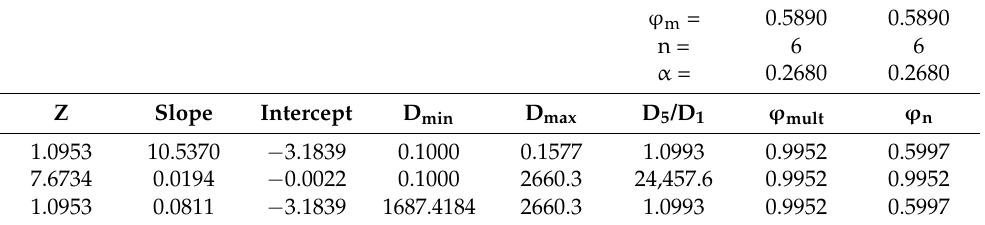
Table 7. Summary of straight lines for three optimum particle distributions with different Z values and different starting particle sizes.